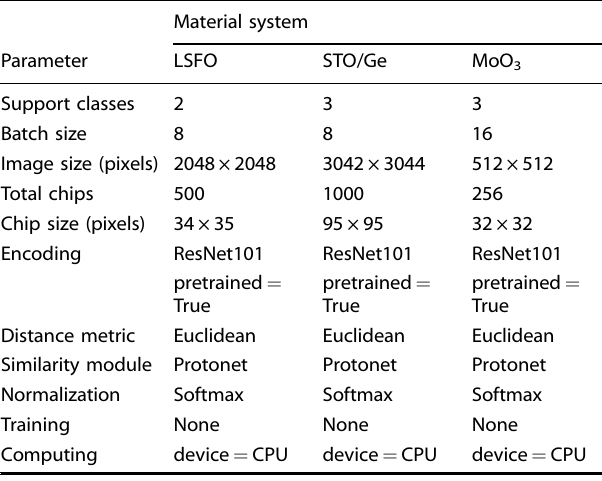
Table 2. Few-shot speci fi c implementation information including model parameters, image information, and computing device used for the images shown in Fig.